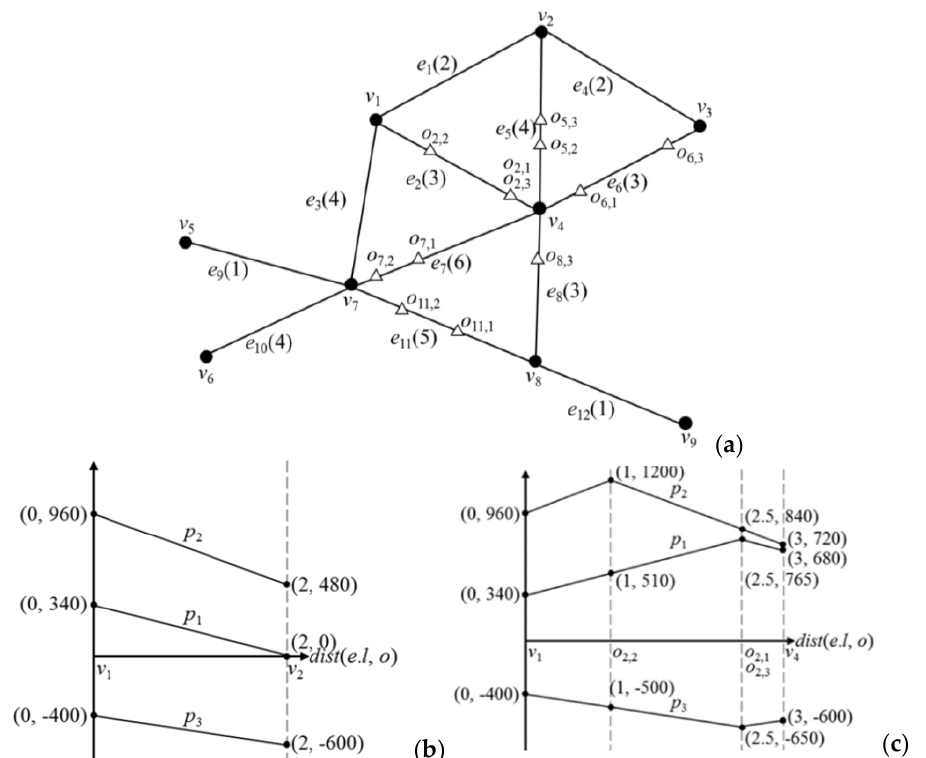
Figure A1. Example of the baseline algorithm: ( a ) road network; ( b ) graph of disp ( p , o ) × CI ( Q , p ) on e 1 ; ( c ) graph of disp ( p , o ) × CI ( Q , p ) on e 2 . Table A1. Information of P p and P n . Set POI Location Impact of POI p 1 v 2 170 P p p 2 v 3 240 P n p 3 v 7 −